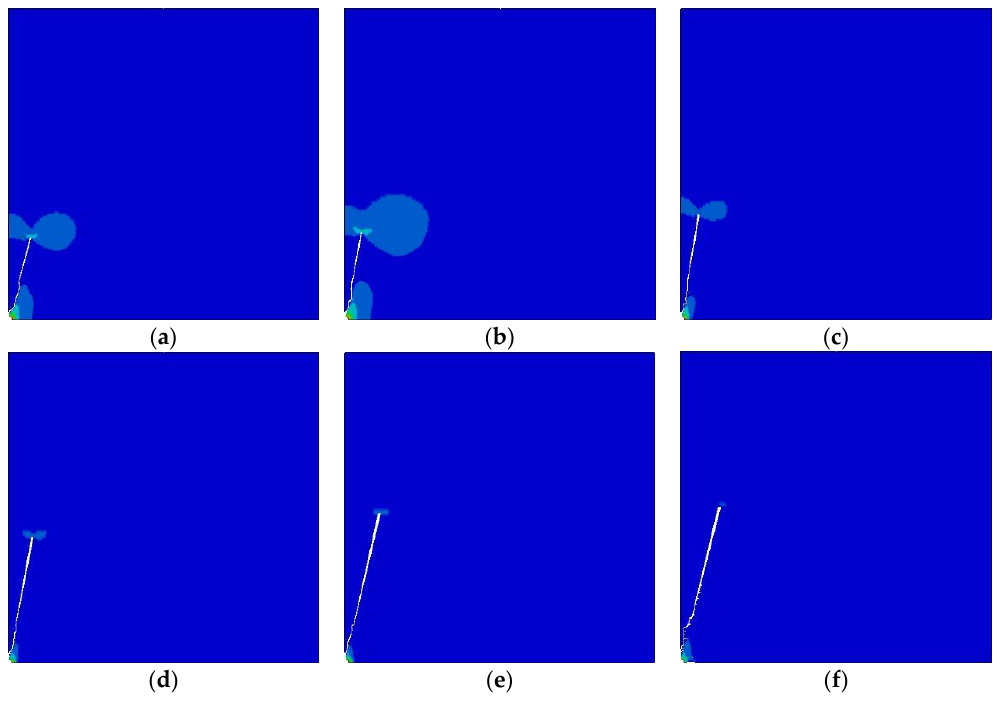
Figure 11. Crack propagation of different models with different impact reduction coefficients: ( a ) reduction coefficient 0.5; ( b ) reduction coefficient 0.58; ( c ) reduction coefficient 0.66; ( d ) reduction coefficient 0.74; ( e ) reduction coefficient 0.82; ( f ) reduction coefficient 0.9.